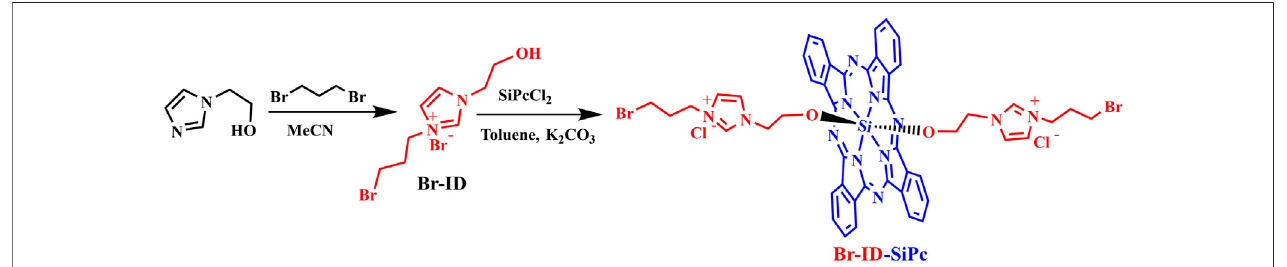
FIGURE 1 | The synthetic route of Br-ID-SiPc.